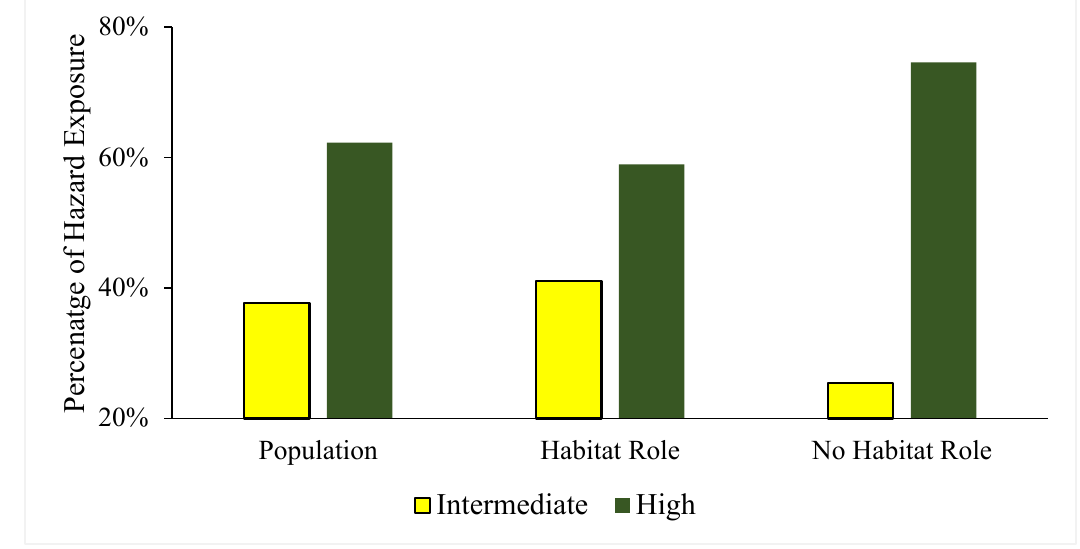
Figure 6. Percentage of people at highest risk in each scenario (with habitat, without habitat and under current sea-levels.